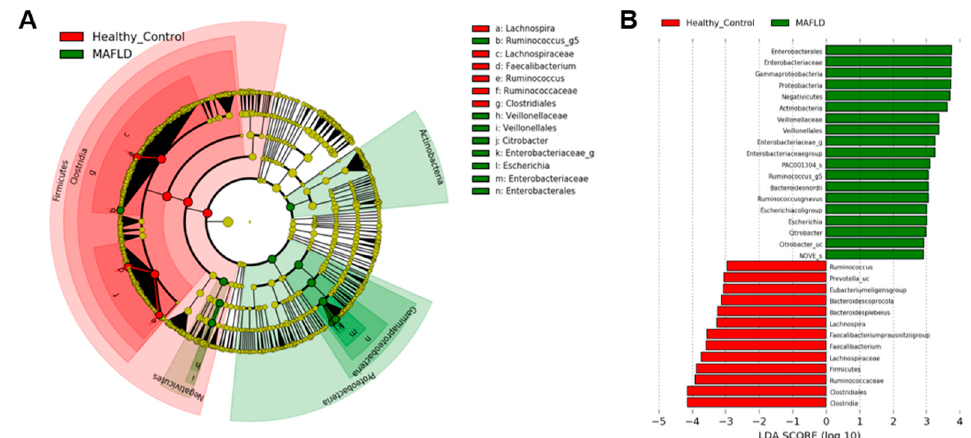
Figure 3. Linear discriminant analysis Effect Size (LEfSe) showing microbiome differences between two groups at various taxonomic levels. ( A ) LEfSe cladogram, ( B ) LEfSe analysis with linear discriminant analysis. Table 2. Abundant taxa in gut microbiome of healthy control and MAFLD patients (phylum, order, family, genus).